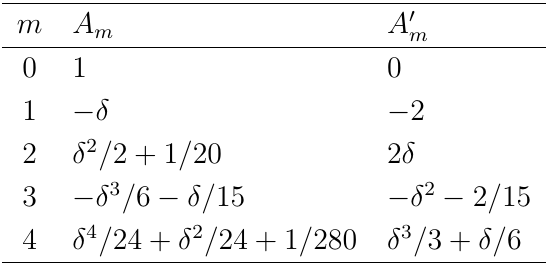
and A (cid:48) in Equation (54) m m